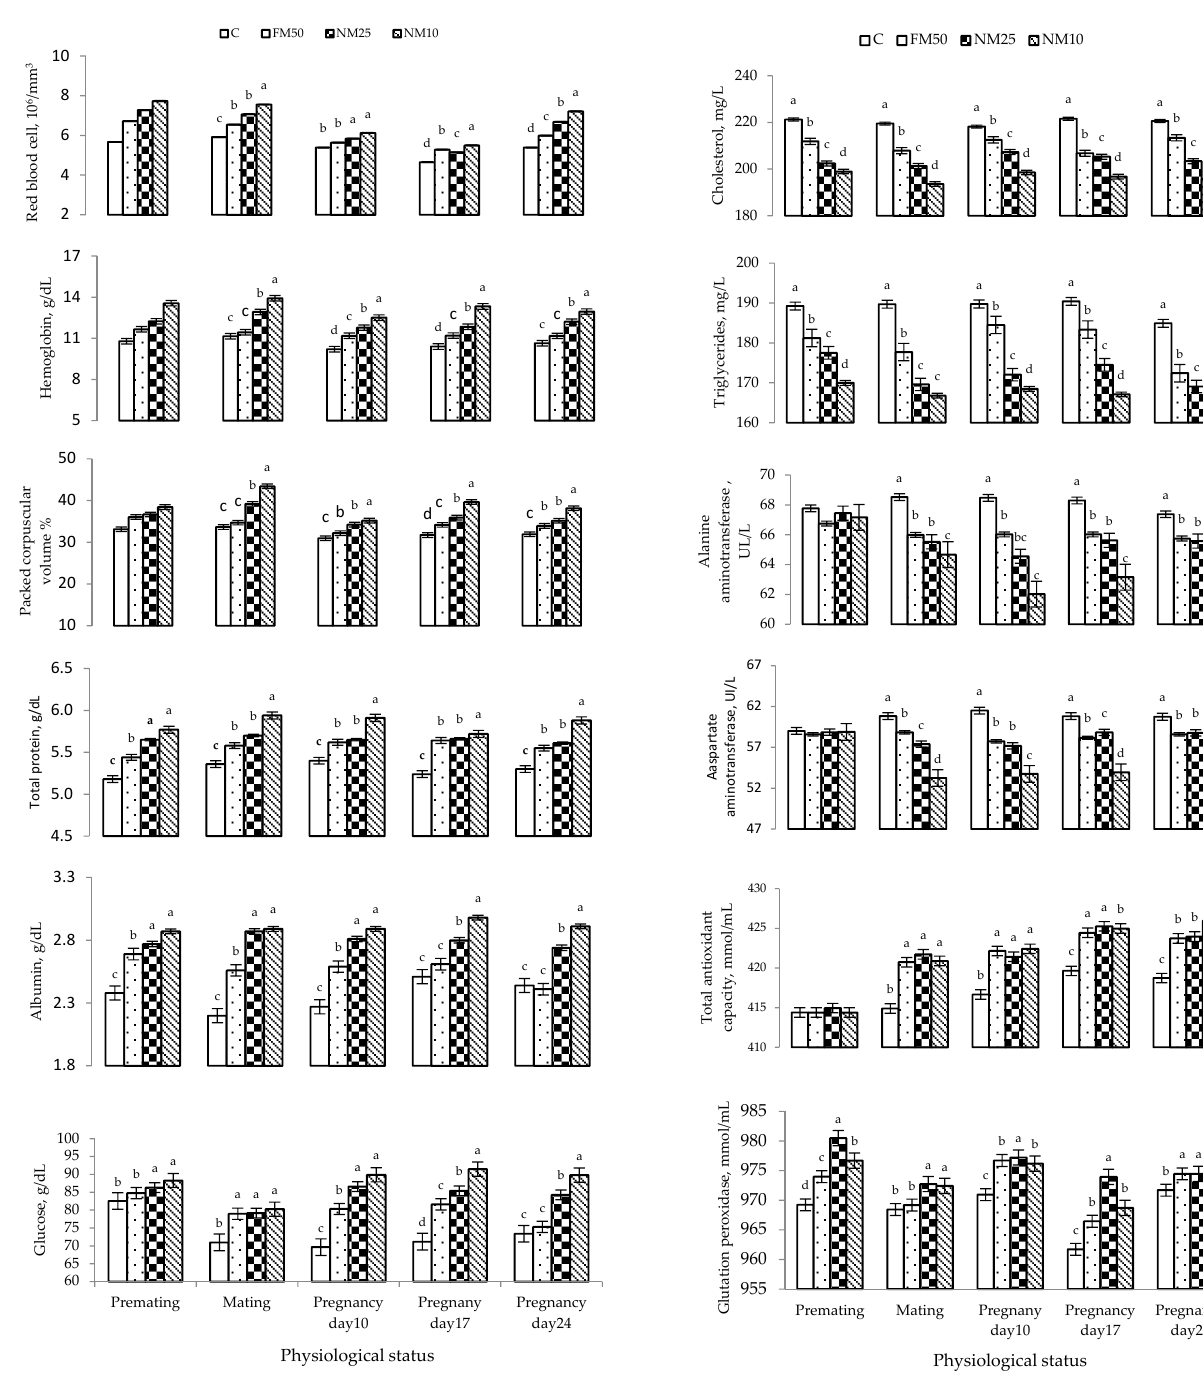
Figure 2. Changes (means ± SEM) in the blood plasma metabolites of rabbit does during the experimental period. C = 0 mg/kg BW MLEE, FM 50 = 50 mg/kg BW MLEE, NM 25 = 25 mg/kg BW nanoencapsulated MLEE and NM 10 = 10 mg/kg BW nanoencapsulated MLEE. Means within the same physiological status having different superscripts (a, b, c, d) differ significantly ( p < 0.05).